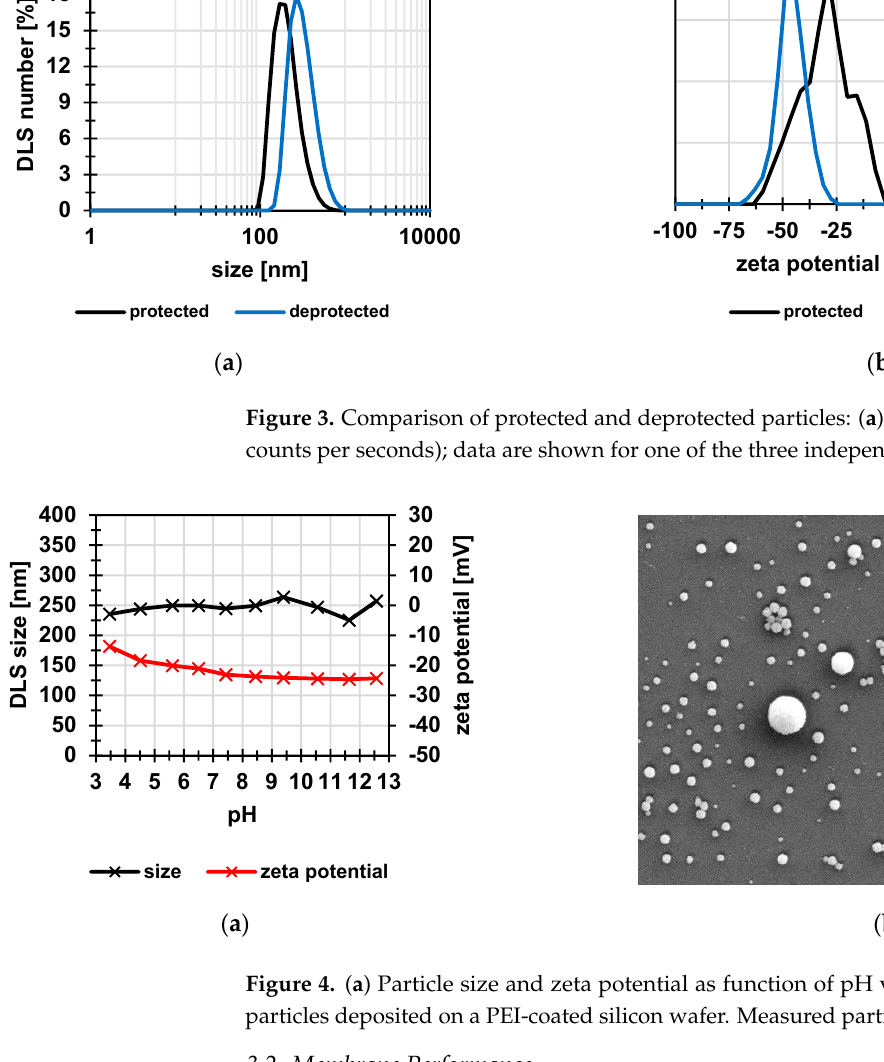
Figure 4. ( a ) Particle size and zeta potential as function of pH value; ( b ) SEM image of protected particles deposited on a PEI-coated silicon wafer. Measured particle size 133 ± 27 nm ( n > 100).